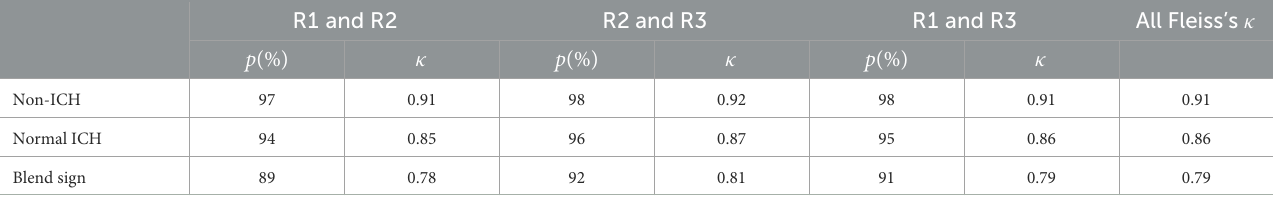
TABLE 2 Reliability of the gold standards for our dataset. R1 and R2 R2 and R3